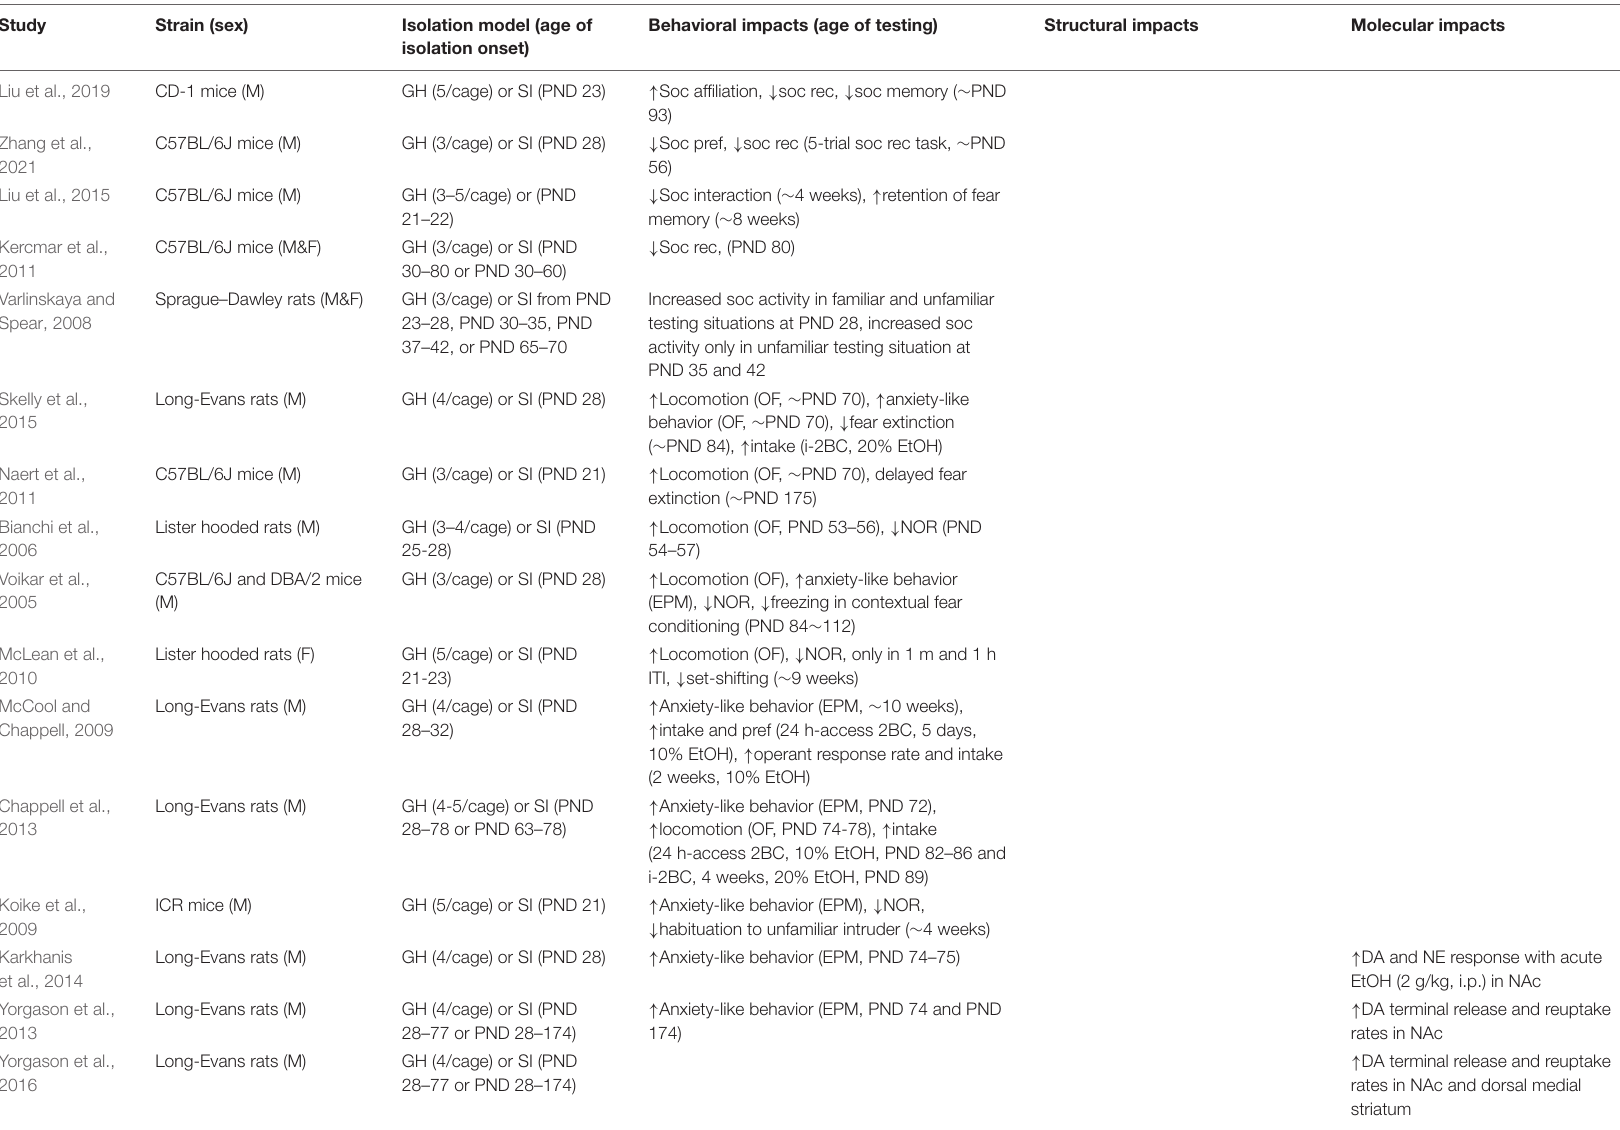
TABLE 1 | Behavioral, structural, and molecular impacts following adolescent social